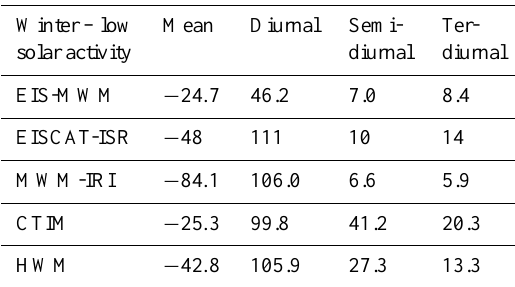
Table 3. As for Table 1 but for autumn season, low solar activity.